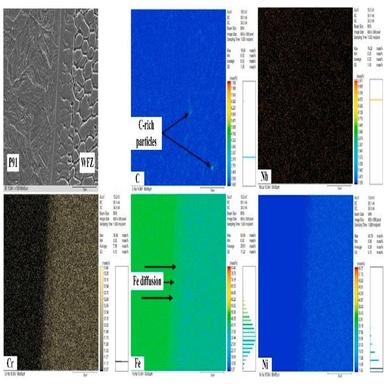
EPMA qualitative analysis of P91 weld interface.